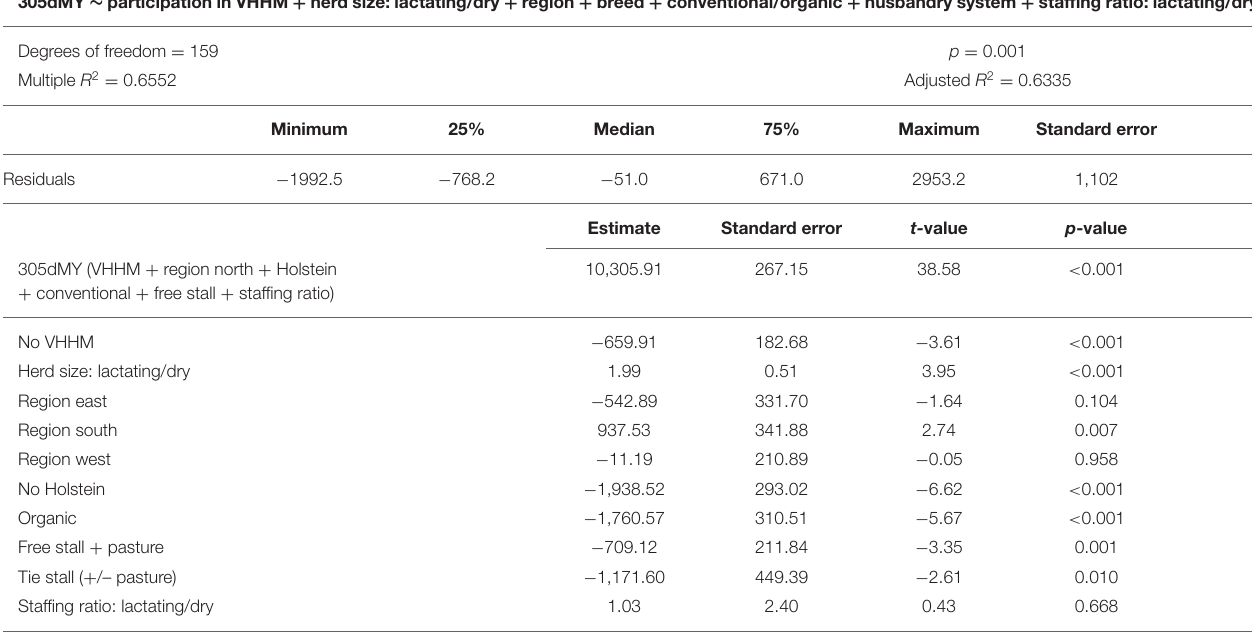
TABLE 5 | All participants: multiple regression models. Multiple regression model: 30 5d MY (Analysis of dependent variable “305dMY” with influencing